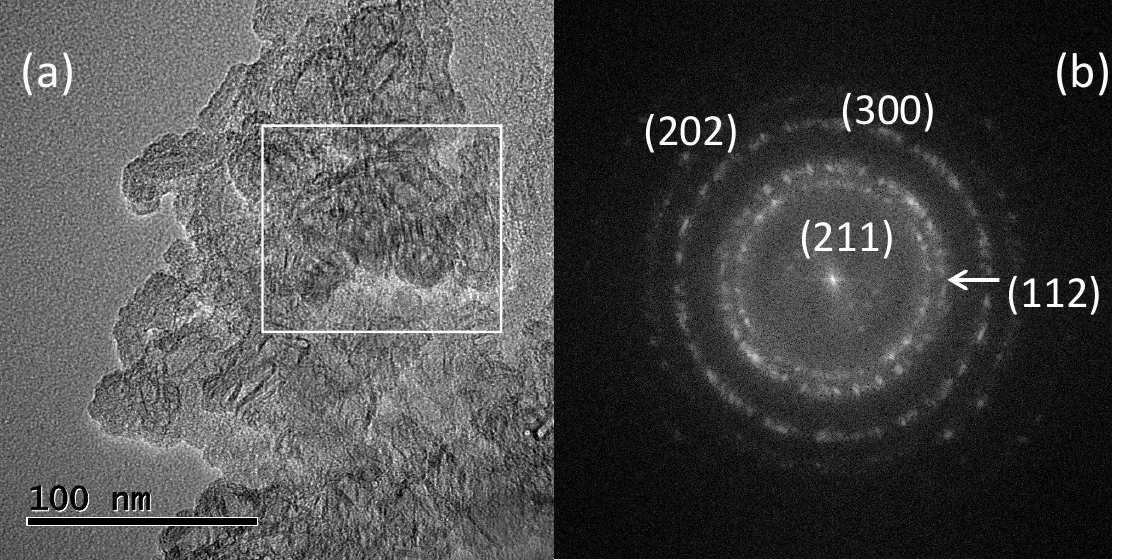
Figure 3. ( a ) HRTEM micrograph of HAp commercial powders. Atomic resolution can be seen. ( b ) FFT applied to the image region within the white rectangle produced a ring pattern. The FFT was indexed.